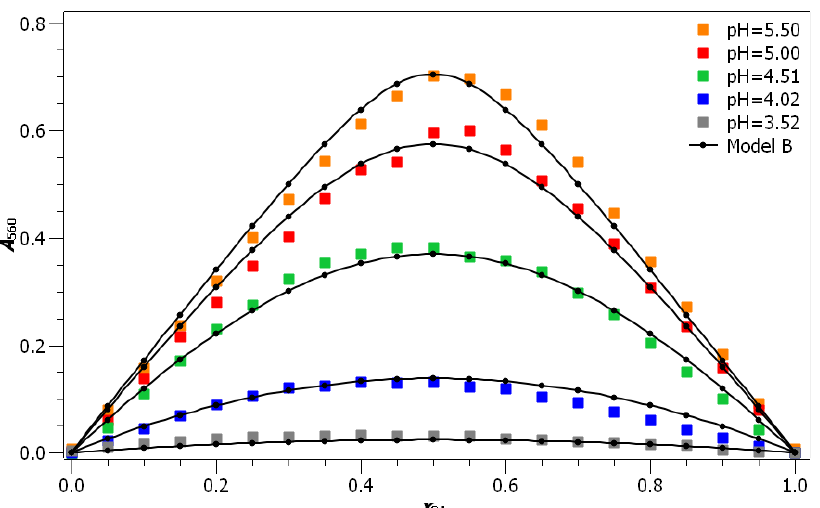
Figure 5. Model function B fitting to the experimental results ( c = 5 · 10 − 4 mol · L − 1 ), where it is assumed that H 2 GA 2 − protonation species reacts with Fe(II) ions to form the coordination compound [H 2 GAFe] ( R 2 = 0.994).